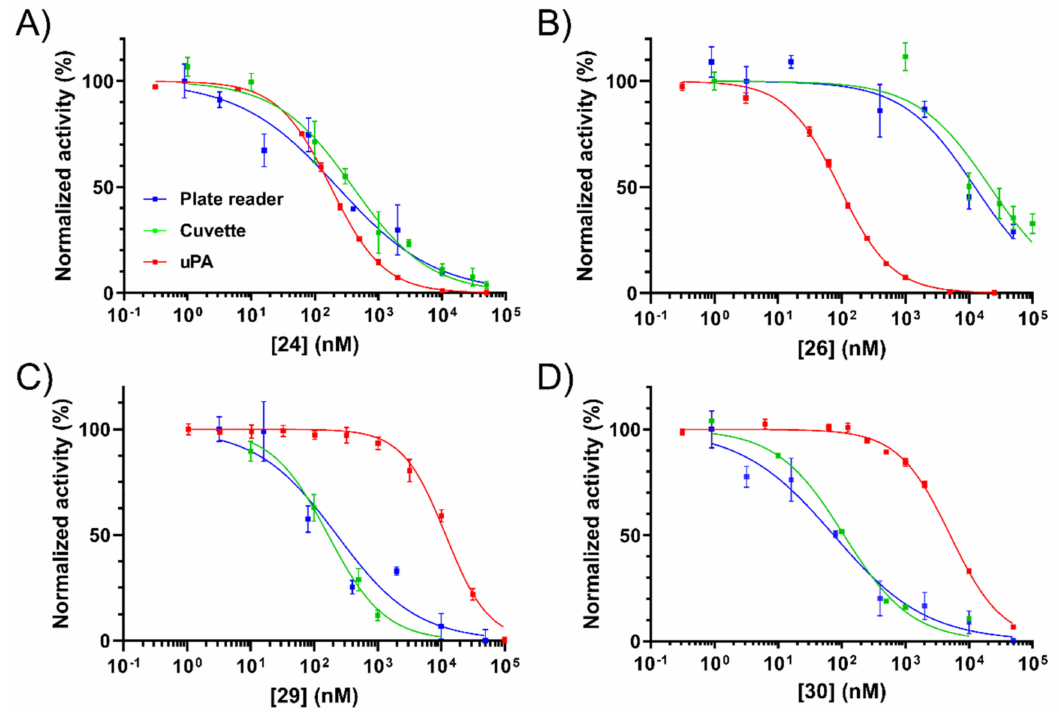
Figure 3. Representative NHE1 and uPA inhibition curves for: ( A ) 24 , ( B ) 26 , ( C ) 29 , and ( D ) 30 . Blue = NHE1 inhibition deter- mined using the plate-reader assay. Green = NHE1 inhibition determined using the cuvette assay. Red = inhibition of human uPA activity. Data points = mean ± SEM; blue and red ( n = 3), and green ( n = at least six technical